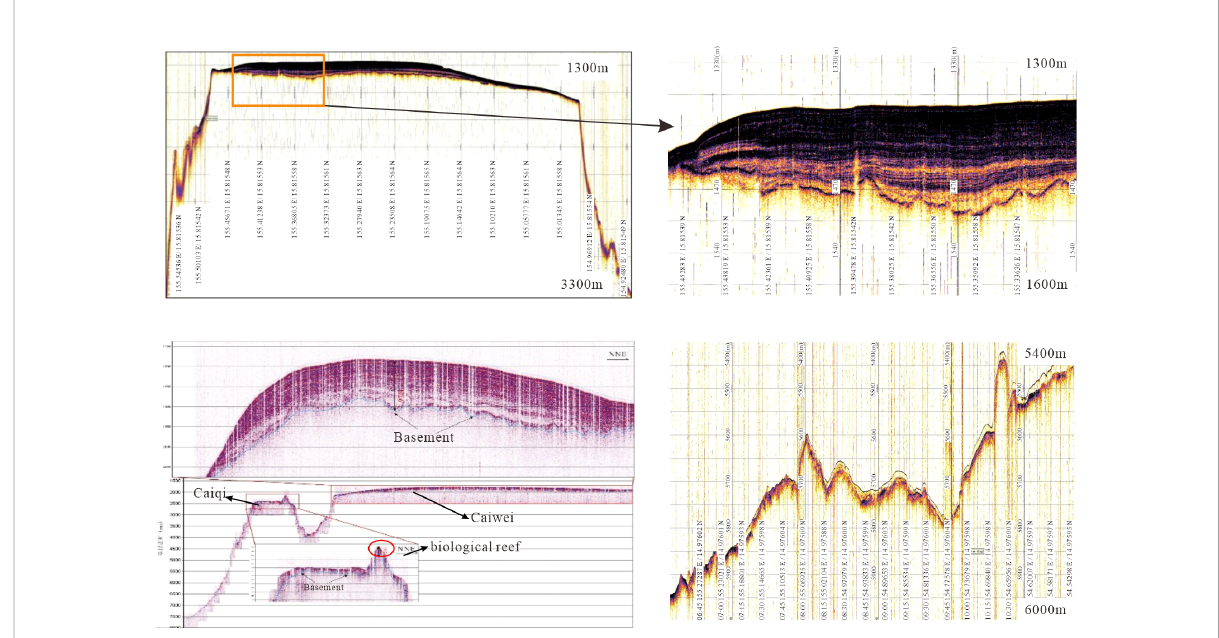
FIGURE 9 Images of sub-bottom pro fi les: (A) Sub-bottom pro fi les of SB1. (B) Sub-bottom pro fi les of SB2; the red circle shows the biological reef with lagoon sedimentation. (C) Sub-bottom pro fi les of